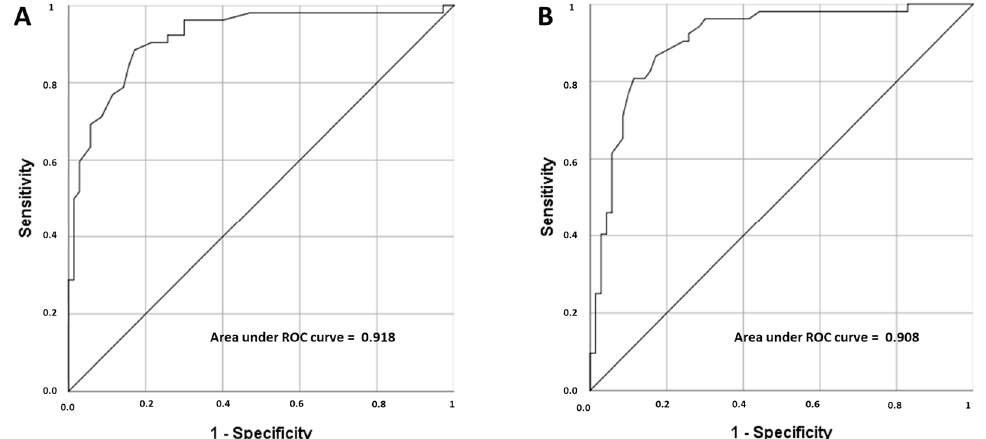
Figure 3. Area under ROC curves for ∆ SC ( A ) and ∆ SC% ( B ), evaluating their accuracy for distin- guishing between hypovolemic hyponatremia and euvolemic hyponatremia. ROC: receiver operator